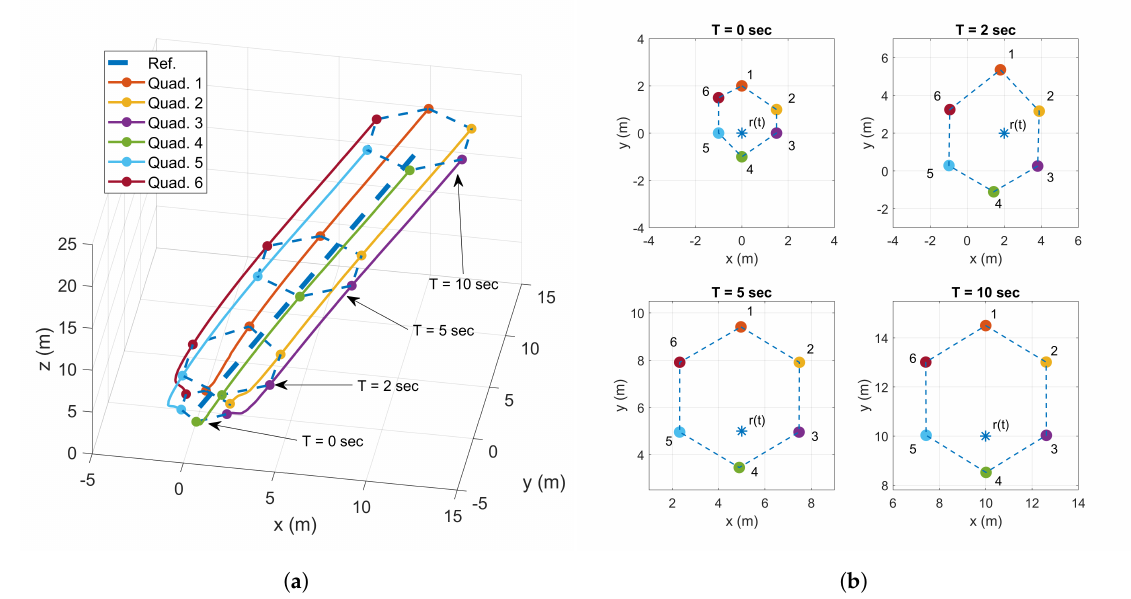
Figure 5. The illustration of formation control. ( a ) Formation flight of the six quadcopters in three-dimensional space. ( b ) Position snapshots of the six quadcopters and r ( t ) projected into the xy